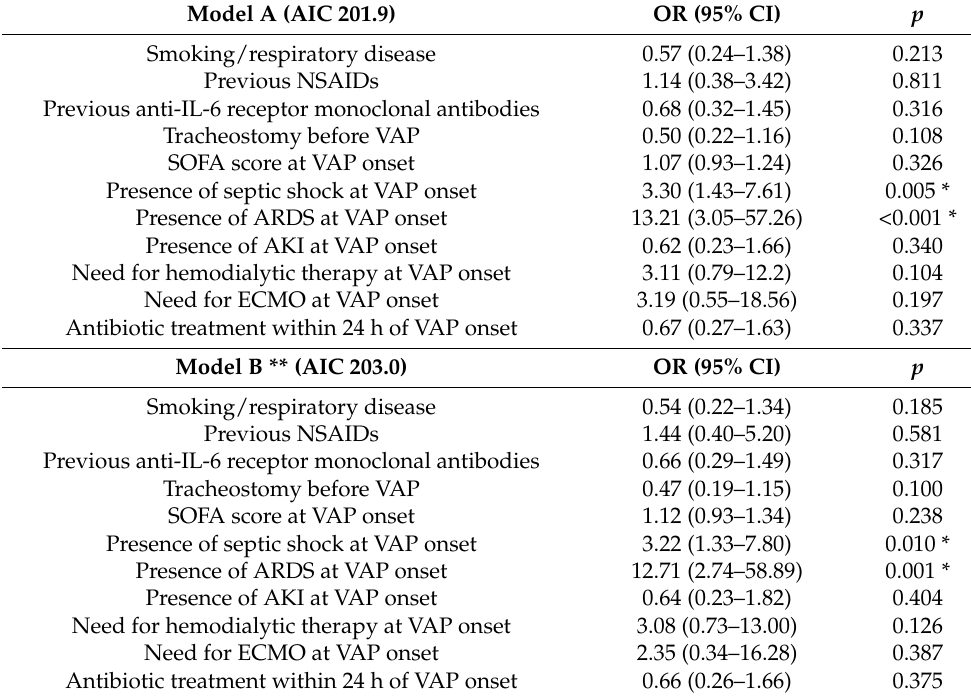
Table 3. Multivariable analysis of independent predictors of 30-day case fatality in critically ill COVID-19 patients with VAP.